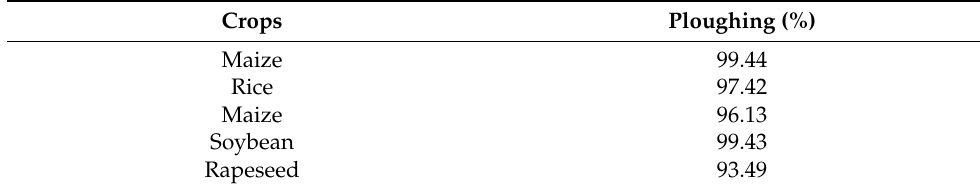
Table 10. Percentage of different crops ploughed by machine.